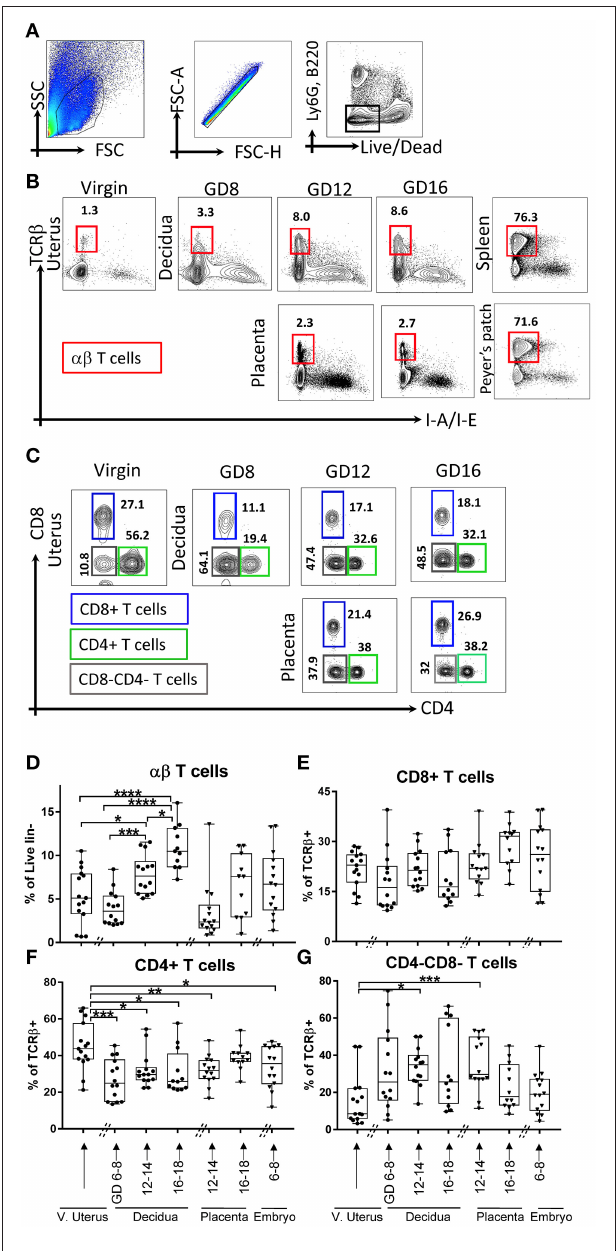
FIGURE 3 | Gating strategy and dynamics of αβ T cells. (A,B) αβ T cells, defined as lin2-[Ly6G neg B220 neg I-A/I-E neg (TCR β + )]. (B) Gating strategy of αβ T cells in murine virgin uterus, decidua and placenta across the gestational age, upper panel showed decidua, lower panel showed as placenta, spleen, and Peyer’s patches used as controls. (C) Gating strategy of T cells subsets, CD4 + T cells, CD8 + T cells, CD4-CD8-T cells. (D) Proportions of αβ T cells out of live lin2-population. (E–G) Proportions of CD8 + T cells out of αβ T cells), proportions of CD4 + T cells out of αβ T cells, proportions of CD4-CD8-T cells out of αβ T cells in murine virgin uterus, decidua, placenta, and embryo across gestational age. n = 11–15 (15 independent experiments), the exact number of animals was summarized in Supplementary Table 3 . The data of virgin uterus were compared with decidua group or placenta (include embryo) group, respectively. Statistical analysis was performed using ANOVA followed by post-hoc Tukey analysis. * p < 0.05, ** p < 0.005, *** p < 0.0005, **** p <